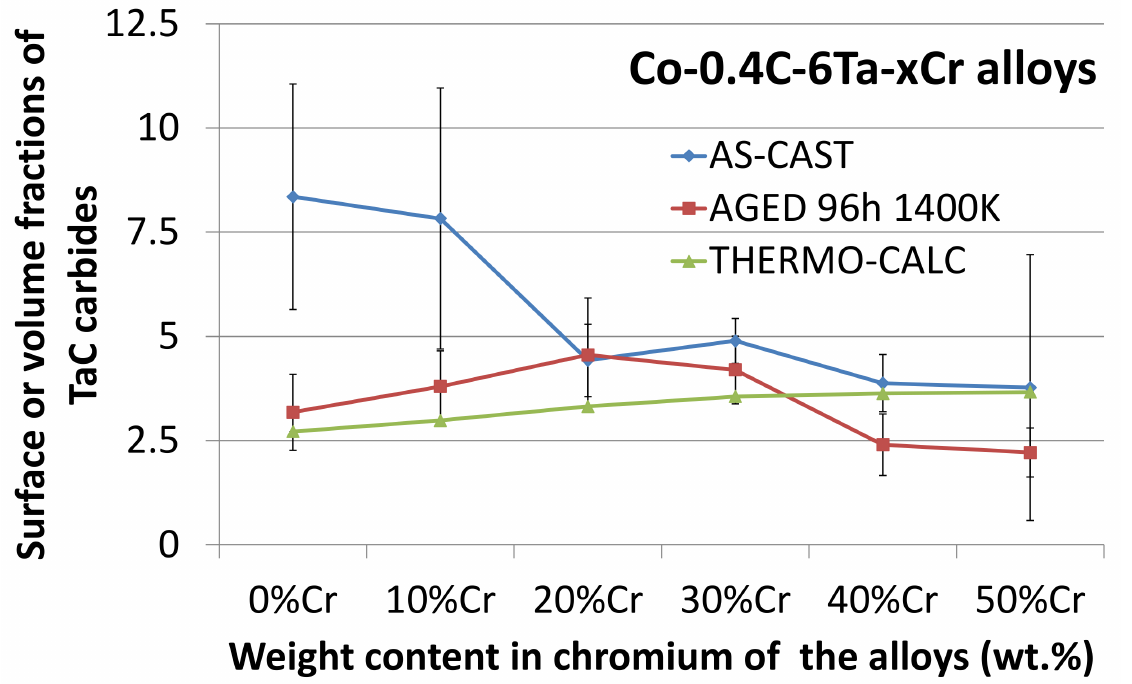
Figure 12. Evolution of the measured or predicted surface volume fraction in TaC versus the chromium content in the